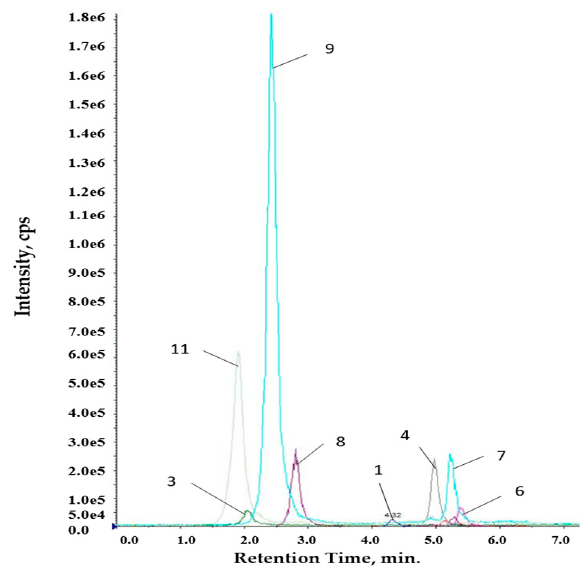
Figure 2. Chromatogram for ethanolic extract.